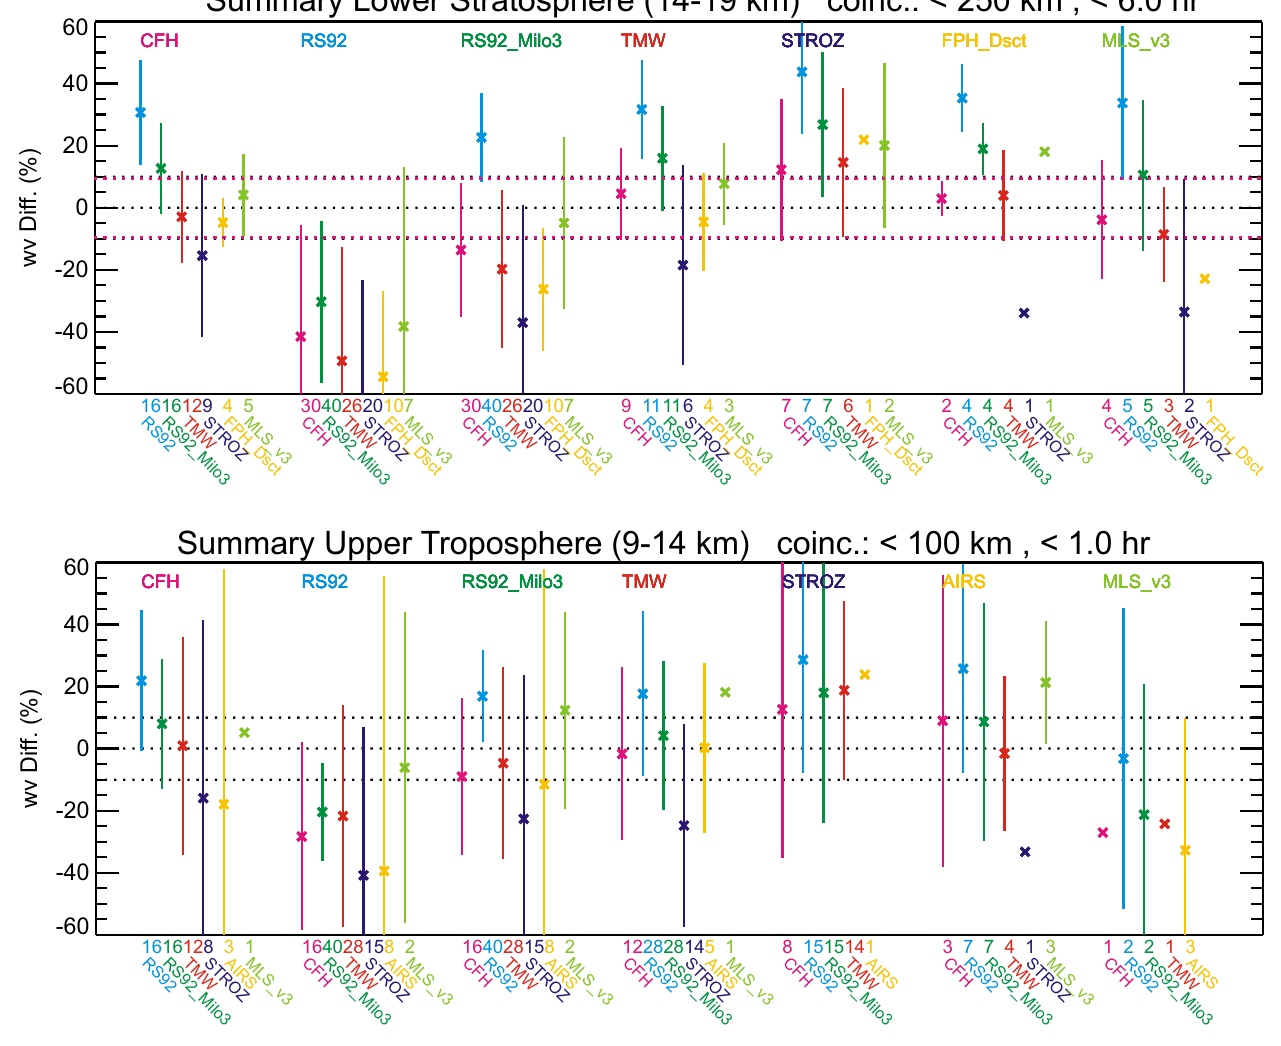
Fig. 17. Same as Fig. 16, but for the upper troposphere (bottom) and lower stratosphere (top).